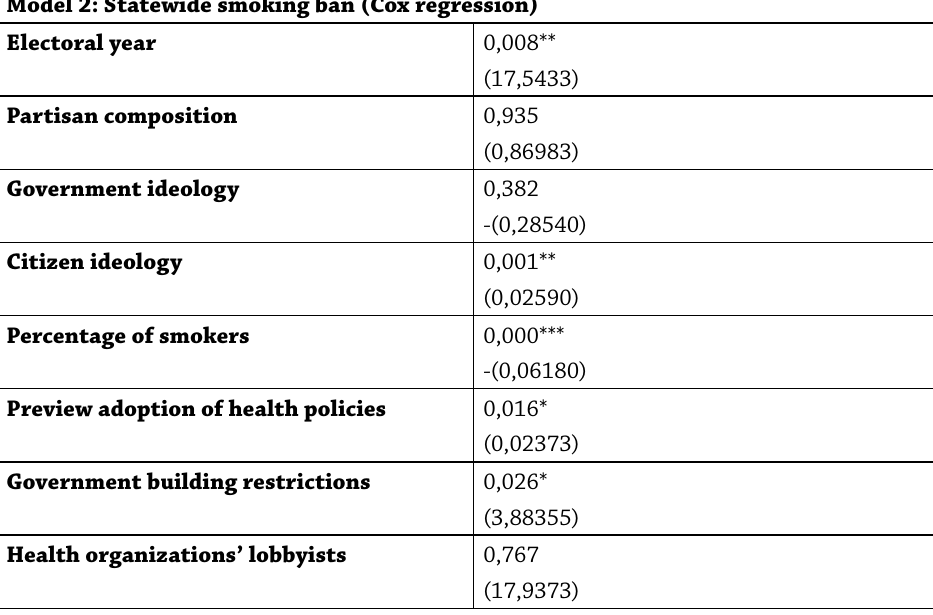
Table 2: Determinants of the Diffusion of Statewide Smoking Ban in the U.S. (1995-2010) Model 2: Statewide smoking ban (Cox